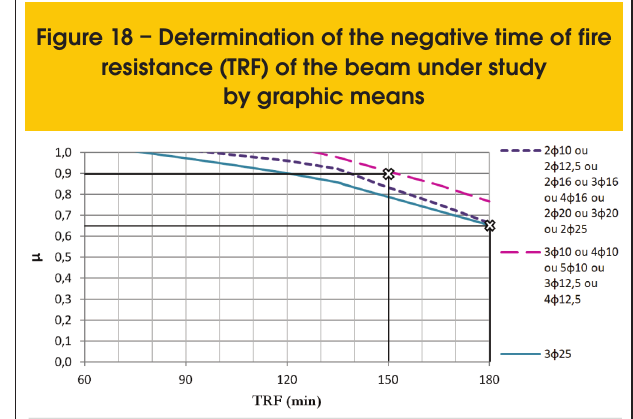
Figure 15 – Diagram of design bending moments in fire before the redistribution